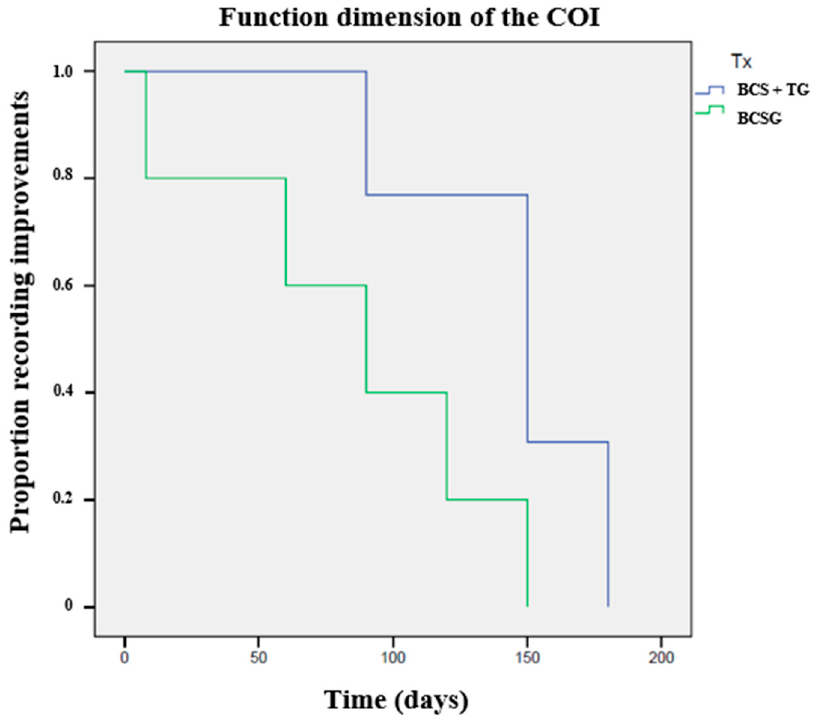
Figure 4. Kaplan–Meier curves demonstrating a significant difference between the Blood Cell Secretome + triamcinolone group (BCS+TG) and the Blood Cell Secretome group (BCSG), in time (days) for the improvement in Function score to reduce below baseline values ( p < 0.01, compared with the logrank test).